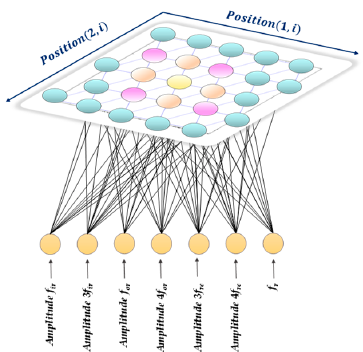
Figure 13. General schematic diagram of the self-organizing map